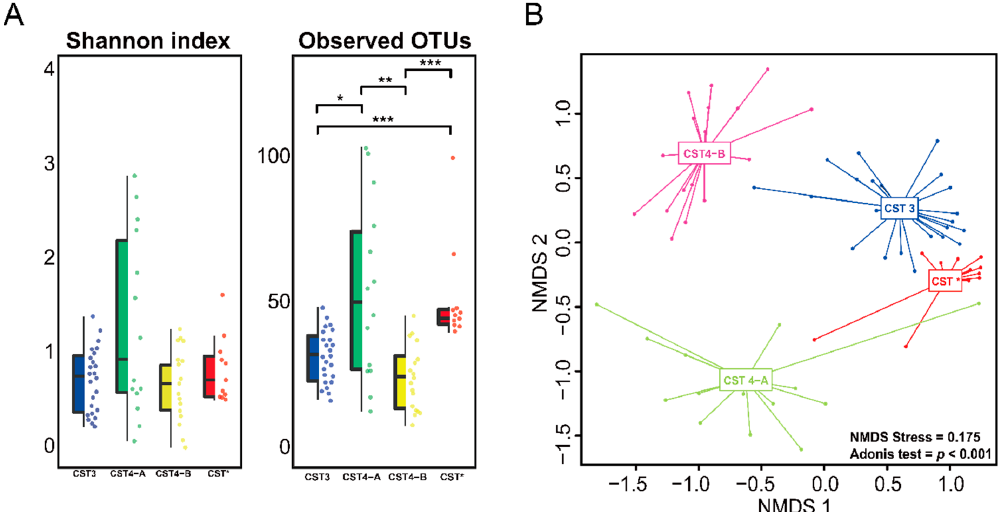
Figure 2. Vaginal microbiome diversity in each CST. ( A ) Alpha diversity including Shannon index and observed operational taxonomic units (OTUs) at the species level. ( B ) Non-metric multidimensional scaling (NMDS) ordination plots based on Bray–Curtis. The microbial communities of each CST type were significantly (Adonis, p < 0.001) di ff erent from each other. *, p < 0.05; **, p < 0.01; ***, p <